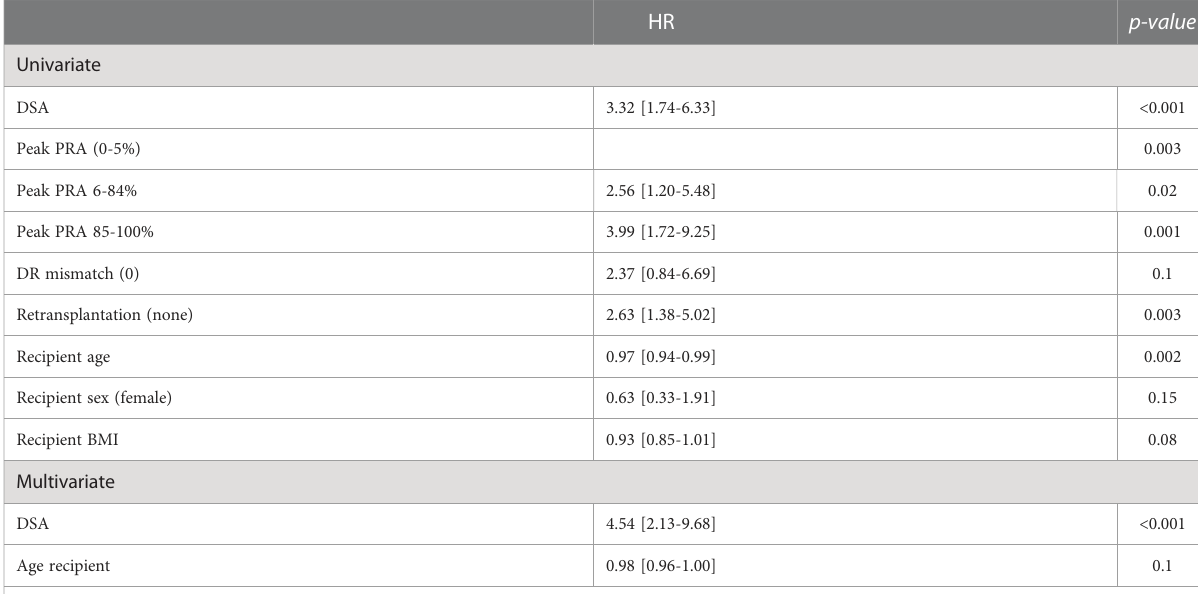
TABLE 2 Univariate and multivariate Cox regression analysis for death censored graft survival in living donor kidney